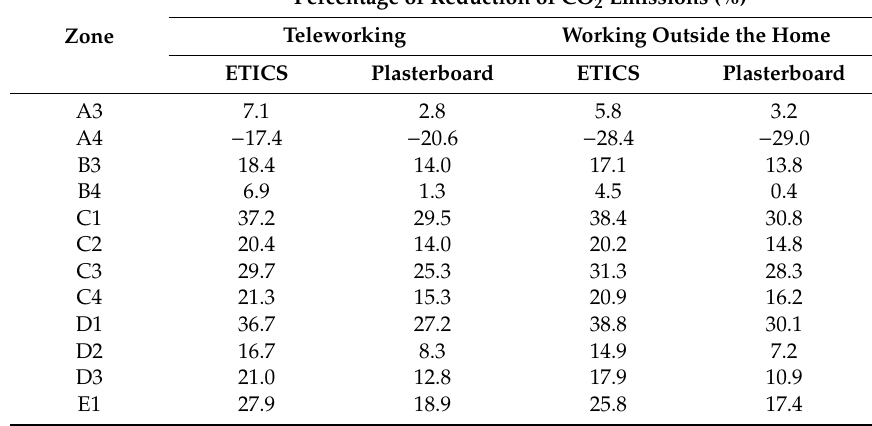
Table 10. Percentage of reduction of CO 2 emissions in 2050 in comparison with emissions in the current